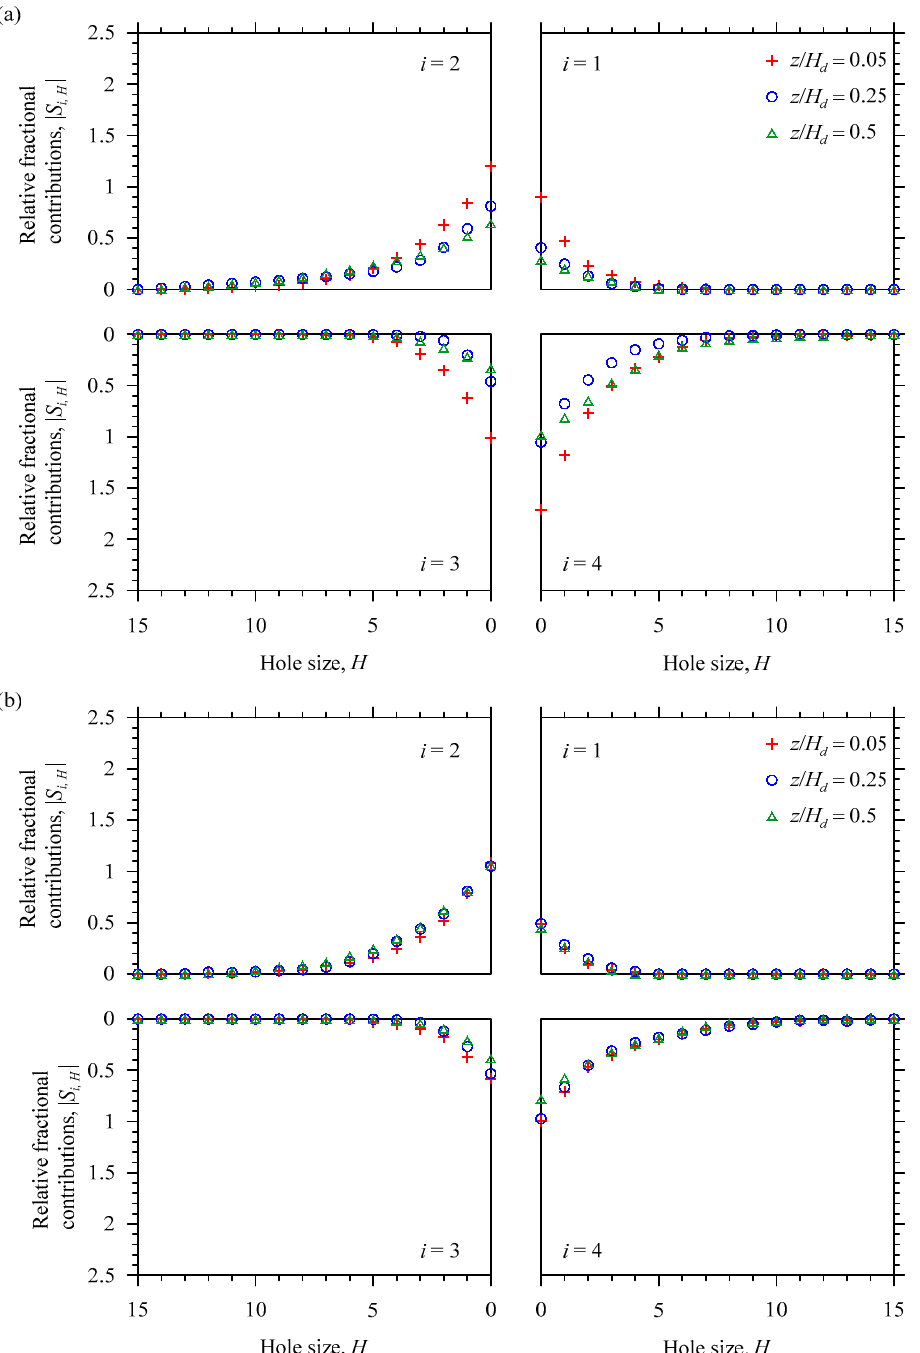
Figure 12. Relative fractional contributions | S i , H | as a function of hole size H in Run 1 at relative streamwise distances (a) x / L d = 1.7 and (b) x / L d = 3.3 for relative vertical distances z / H d = 0.05, 0.25 and 0.5.